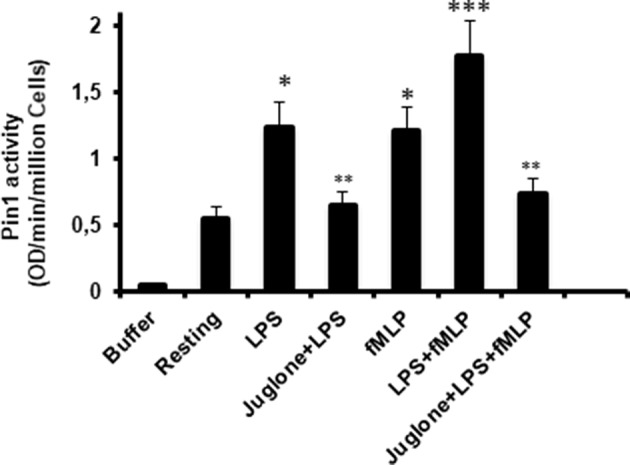
Pin1 is activated by LPS, fMLP, and LPS + fMLP in neutrophils and Juglone markedly decreased Pin 1 activity. Neutrophils were incubated in the absence and presence of Juglone (400 nM for 20 min) and then treated with LPS (5 μg/mL), fMLP (10−7 M), or LPS + fMLP before lysis. Pin1 activity was determined by measuring the absorbance of free pNA cleaved from Trp-Phe-Tyr-Ser (PO3H2)-Pro-Arg-pNA Suc at 410 nm. Results are expressed as Optical Density (OD)/min/million cells. Data are mean plus or minus SEM of 8 experiments. p < 0.01 as LPS and fMLP compared to resting cells (*); Cells treated with juglone compared to untreated cells (**); and LPS+fMLP as compared to LPS alone or fMLP alone (***).